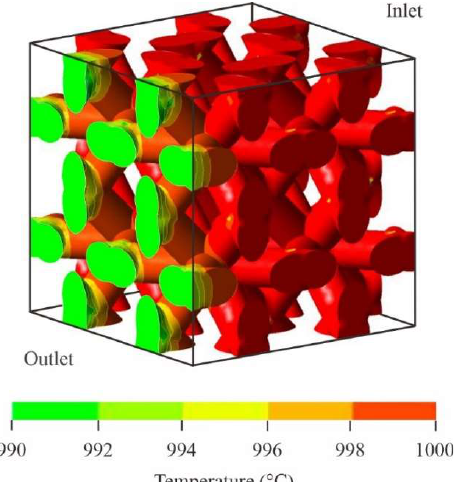
Figure 7. The surface pressure distribution on the yttria-stabilized zirconia (YSZ) lattices simulated using the finite element method (FEM). Displayed yellow and blue contours indicate high and low-pressure loads applied from the molten salt, permeating and moving between the sterically propagated 12-coordinated lattices.